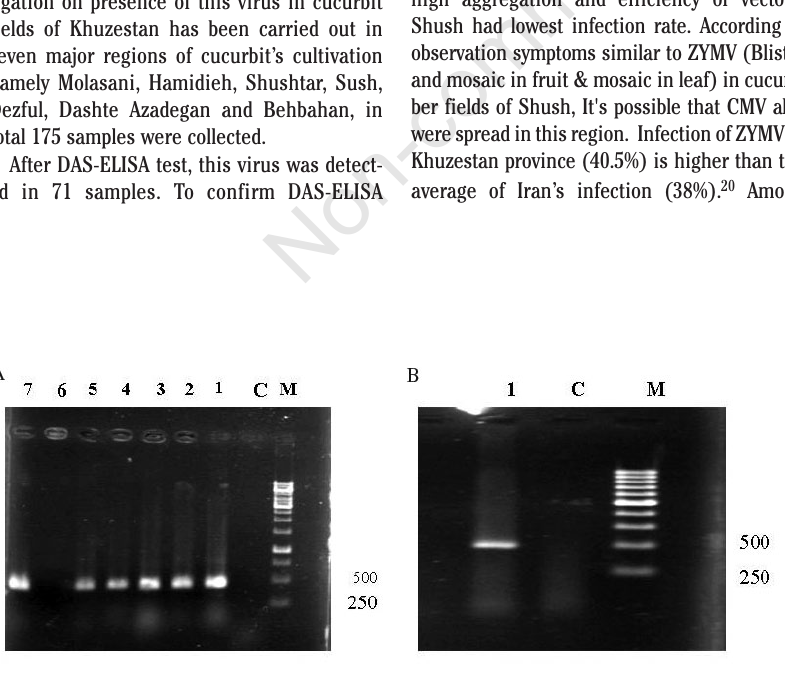
Figure 3. Bands of RT-PCR products of Khuzestan isolates. M: marker 1kb (Gene Ruler™ 1Kb, Fermentas) & C:Negative control. (A): 1-Molasani, 2- Hamidieh, 3- Shushtar, 4- Shush, 5- Dezful, 6- whole well, 7- Dashte Azadegan